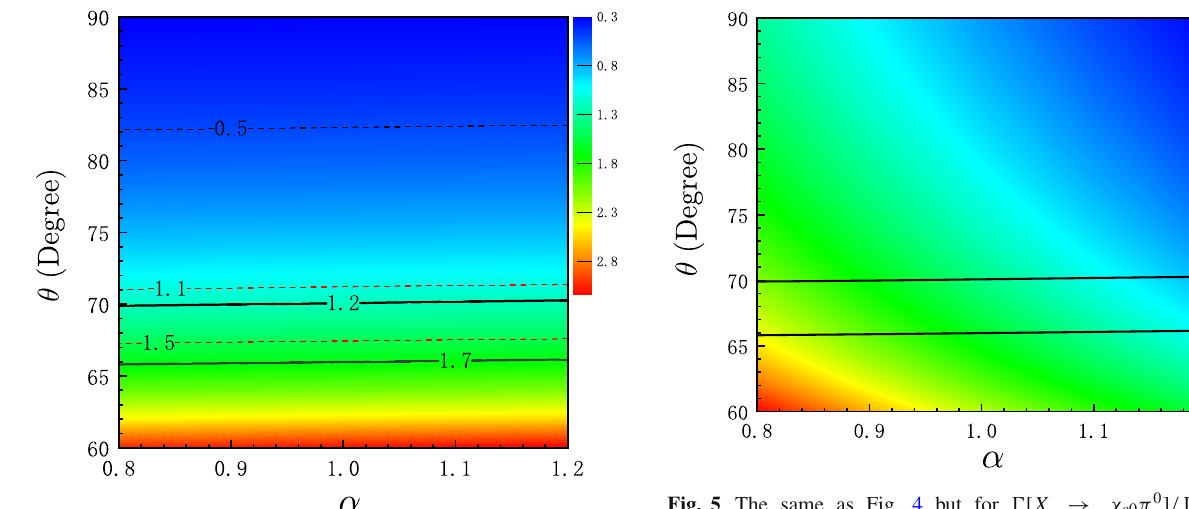
Fig. 5 The same as Fig. 4 but for (cid:5) [ X → χ c 0 π 0 ] /(cid:5) [ X →